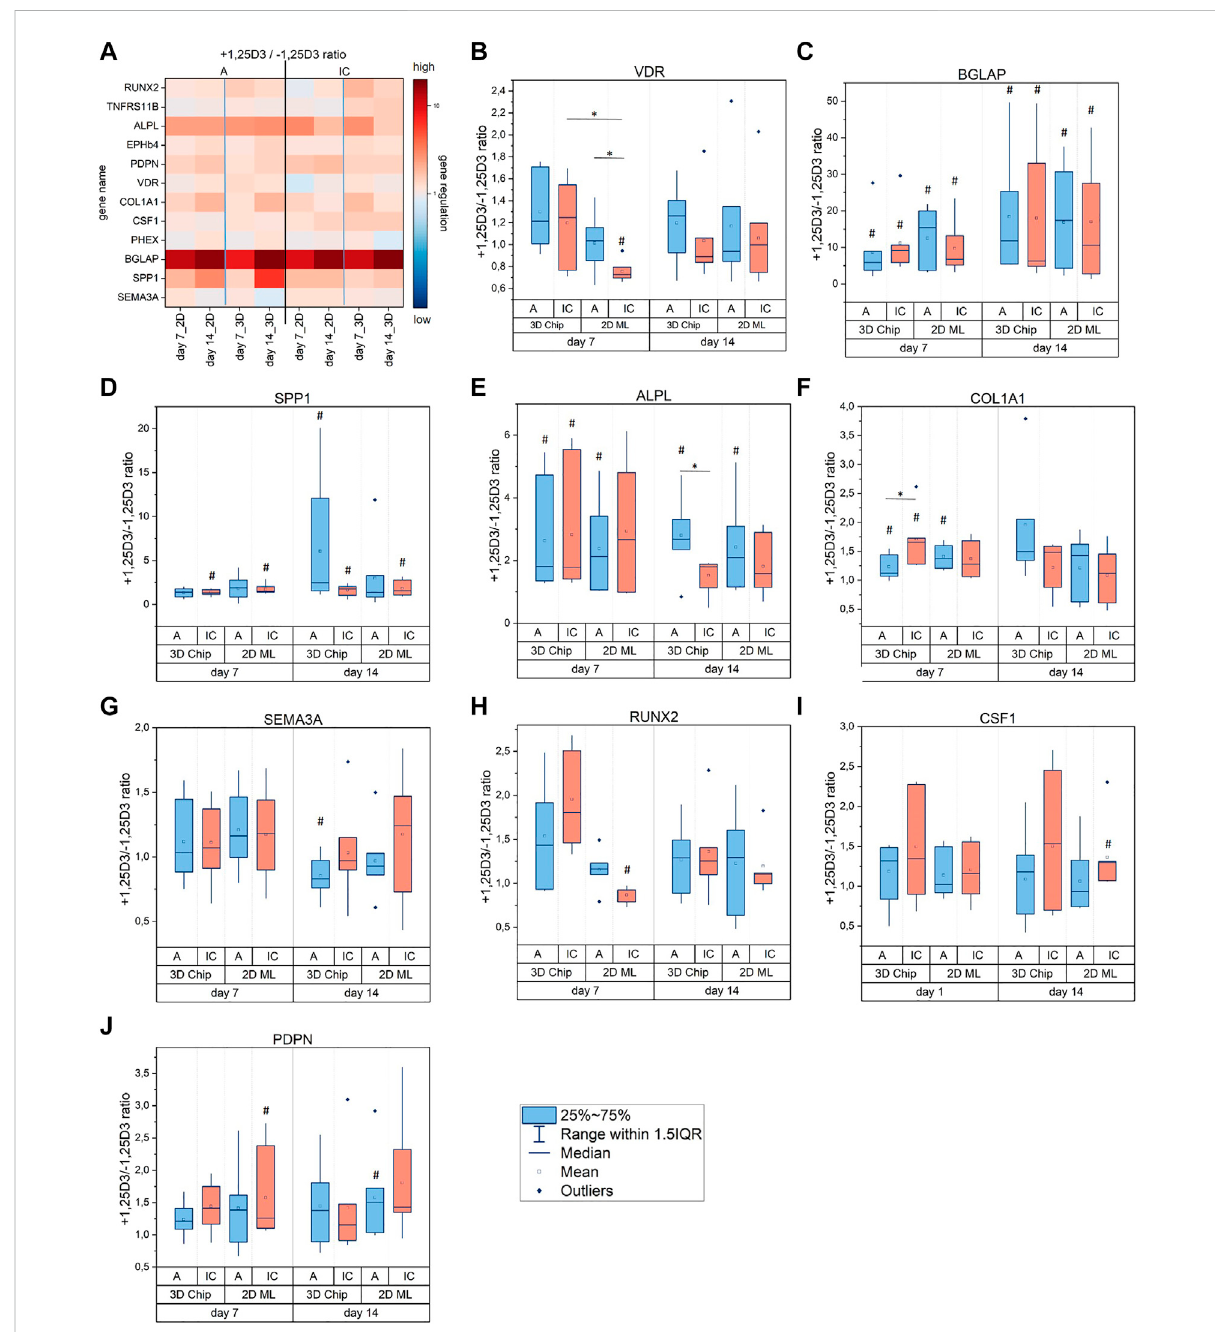
FIGURE 6 (A – J) Effect of 1,25D3 treatment on gene expression in osteoblasts derived from alveolar bone (hOB-A, blue) and iliac crest (hOB-IC, red). The cells werecultured in3D-microchipand 2DML culture underosteogenicconditionsfor 7and 14 days with orwithout (+/-)additionof 1,25D3(1,25- dihydroxyvitamin D3). The copy numbers of the target genes were normalized to copy numbers of the reference gene HPRT1 (hypoxanthine phosphoribosyl-transferase1).Theeffectof1,25D3treatmentisgivenbythe+1,25D3/-1,25D3ratioofnormalizedcopynumbersanddescribes the fold expression of biomarkers in 1,25D3-treated versus untreated cell cultures. A ratio of 1 means no regulation, > 1 up-regulation, and < 1 down- regulation. # p < 0.05forcomparisonof1,25D3treatedwithnon-treatedcultures(+1,25D3vs.-1,25D3);* p < 0.05forcomparisonofthe1,25D3effect between culture modes, i.e. culture con fi guration, time and cell origin; Wilcoxon signed-rank test, n = 7 donors; n = 5 donors for